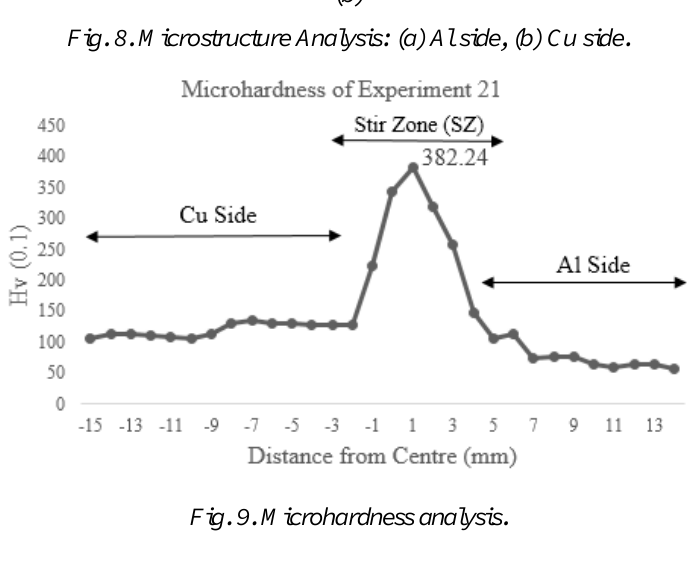
Fig. 8. Microstructure Analysis: (a) Al side, (b) Cu side.